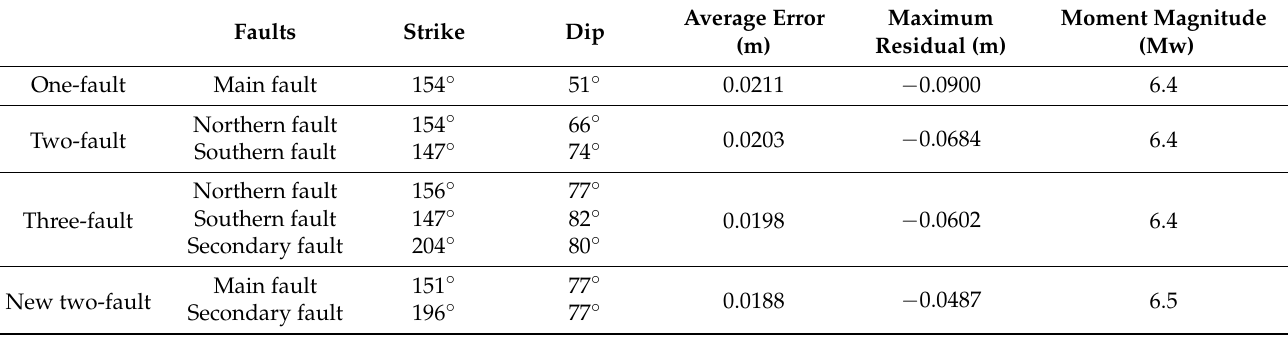
Table 2. Parameters of finite fault